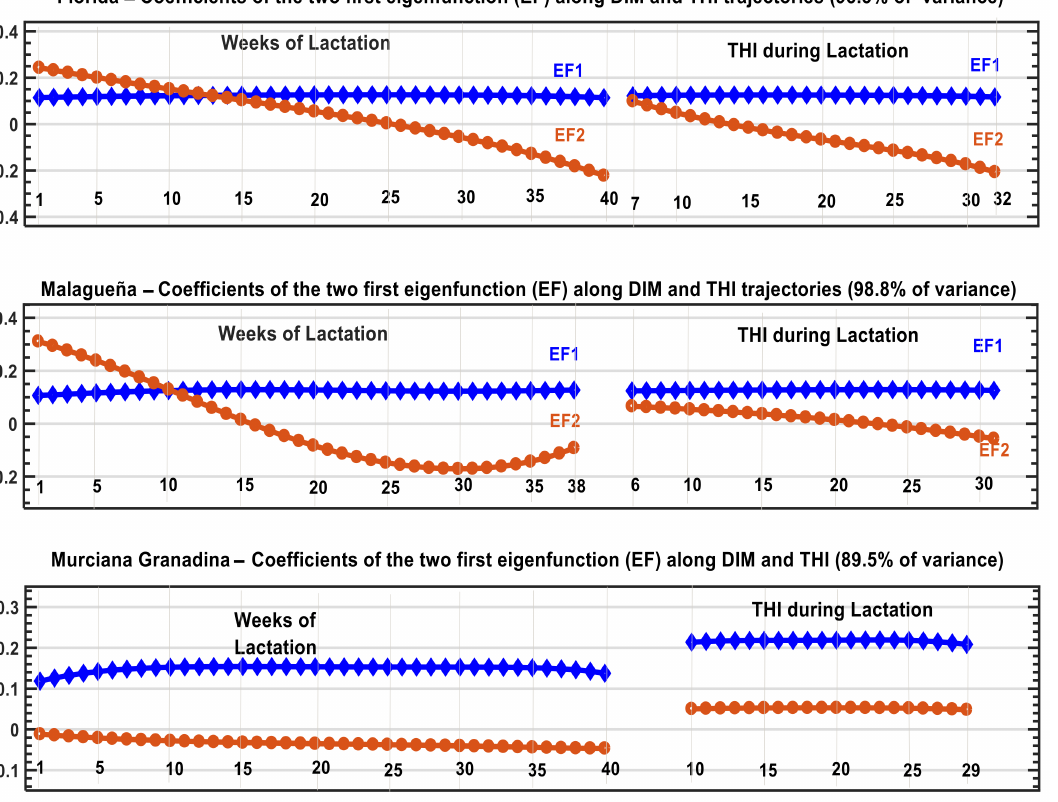
Figure 6. Eigenvector coefficients and percentage of variance explained by the two first Principal Components of Breeding Values estimated for different points of the trajectories of THI and week of lactation in three dairy goat breeds in